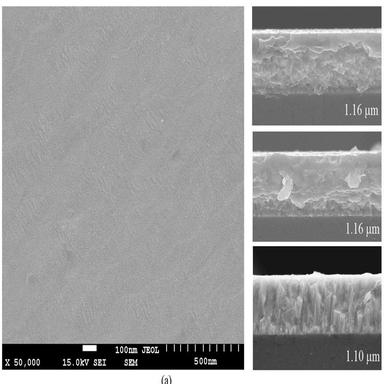
Top-view SEM images and cross-sectional images captured at three regions of each sample: (a) untreated and (b) annealed films; film thickness is specified in the figure.